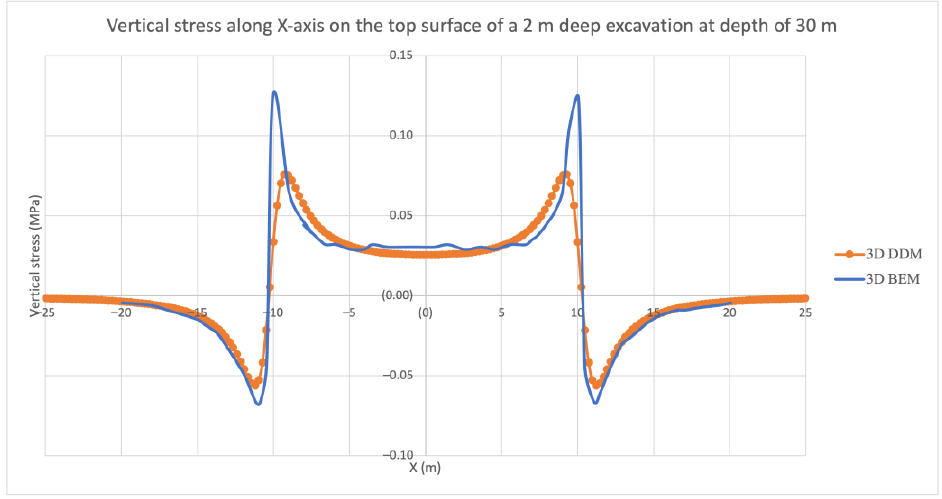
Figure 4. Comparison of solutions using 3D DDM and 3D BEM for a model of underground excavation.